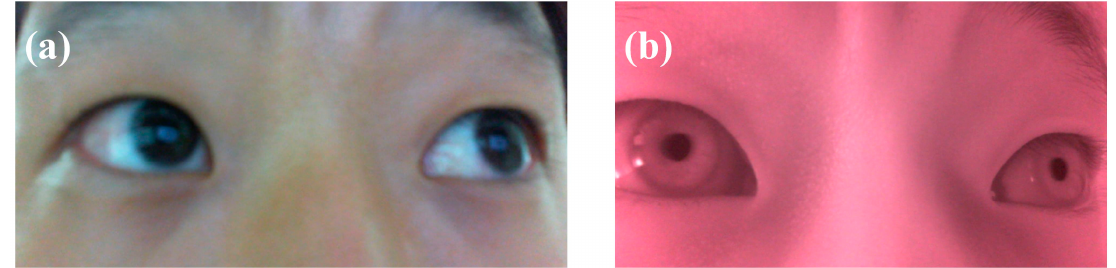
Figure 2. Comparison between on images of a person’s eye taken by commercial cameras; ( a ) LifeCam HD-5000 (general camera), ( b ) LifeCam HD-5000 with IR pass filter (night vision camera).